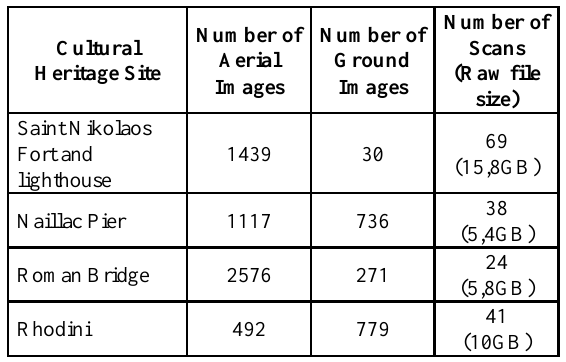
Table 1 . Summary of acquired